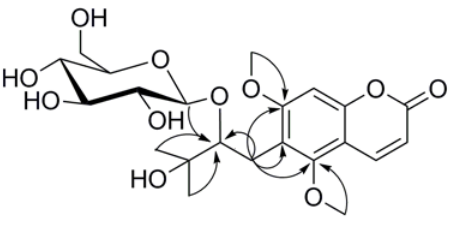
Figure 6. Key HMBC (H → C) correlations for compound 1 .